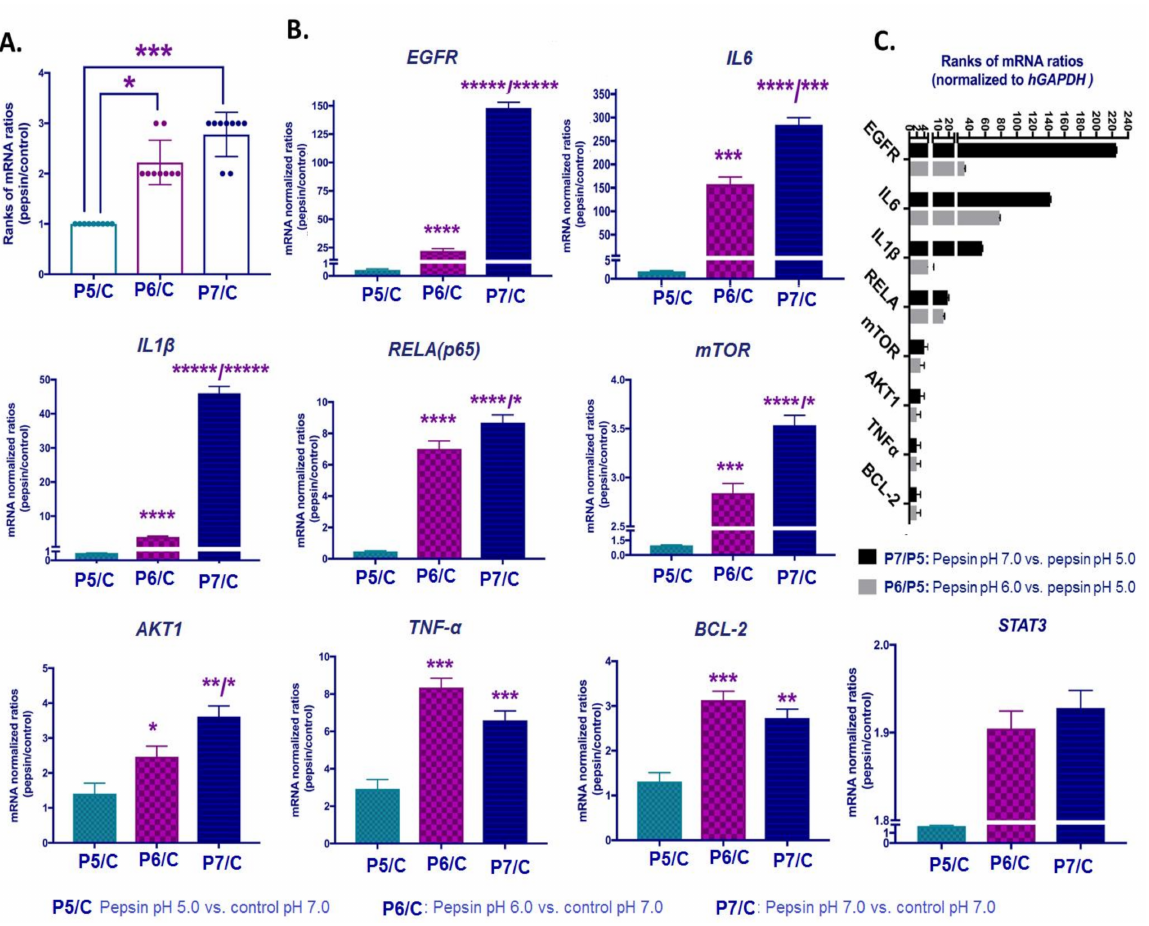
Figure 6. The pepsin-effect on transcriptional activation of EGFR-related signaling pathway in HCs exposed to weakly acidic pH 5.0, slightly acidic pH 6.0 and neutral pH 7.0. ( A ). Columns represent mRNA ratios of pepsin at pH 5.0, 6.0 and 7.0 vs. control treated-groups, by qPCR. ( B ) Columns represent mRNA levels of each analyzed gene in pepsin vs. control treated groups. ( C ) Graph depicts the mRNA ratios of EGFR, IL6, IL1 β , RELA(p65), mTOR, AKT1 and BCL2, in HCs exposed to pepsin at pH 7.0 or pH 6.0 relative to pepsin at pH 5.0. (Normalized mRNAs to hGAPDH reference control; mean ± standard error of two independent experiments). ( t -test; multiple comparisons by Holm-Sidak, * p < 0.050; ** p < 0.005; *** p < 0.0005; **** p < 0.00005; ***** p < 0.000005; GraphPad Prism 7.0; means ± SD of three independent